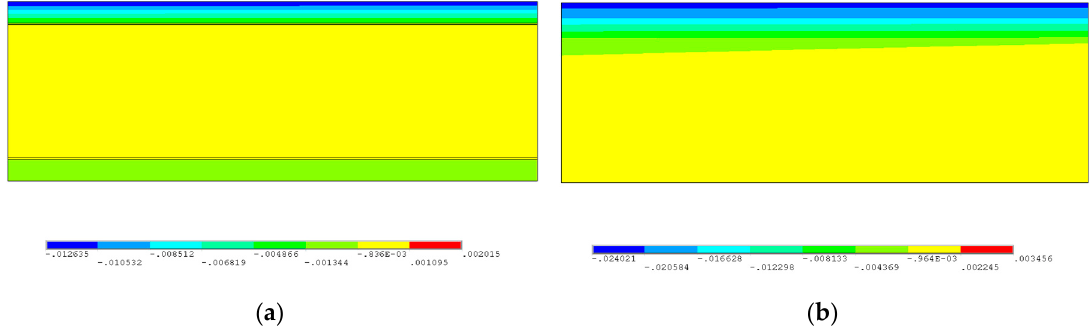
Figure 10. Comparison of Y-direction strain distributions between the SCLP and the SLSP at 100 seconds: ( a ) SCLP; ( b ) SLSP.